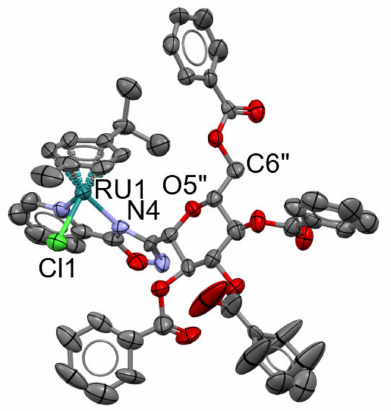
Figure 2. ORTEP view of Ru-1 at a 50% probability level, with a partial numbering scheme. Only one of the complexes in the asymmetric unit is shown. Hydrogen atoms and the PF 6 − counter ion, as well as solvent chloroform molecules, are omitted for clarity.